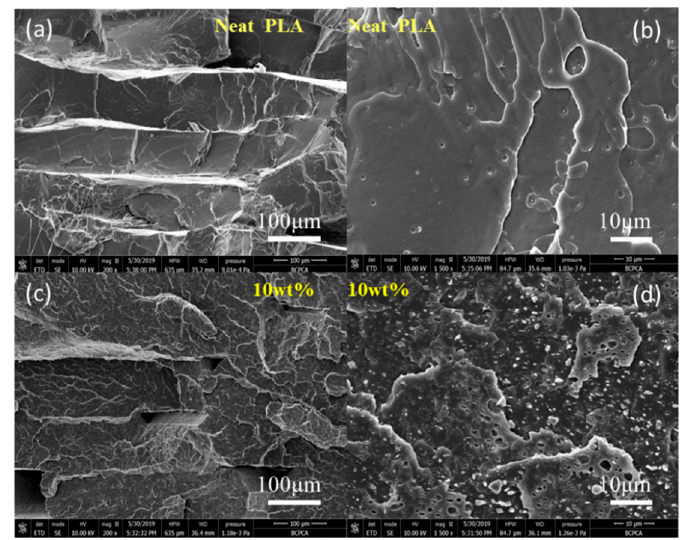
Figure 4. SEM micrographs of the cross-section of 3D printed tensile specimens after wetting-off in liquid nitrogen. ( a , b ) Neat PLA with different magnification. ( c , d ) PLA/10 wt% CLRS-1 composite with different magnification.